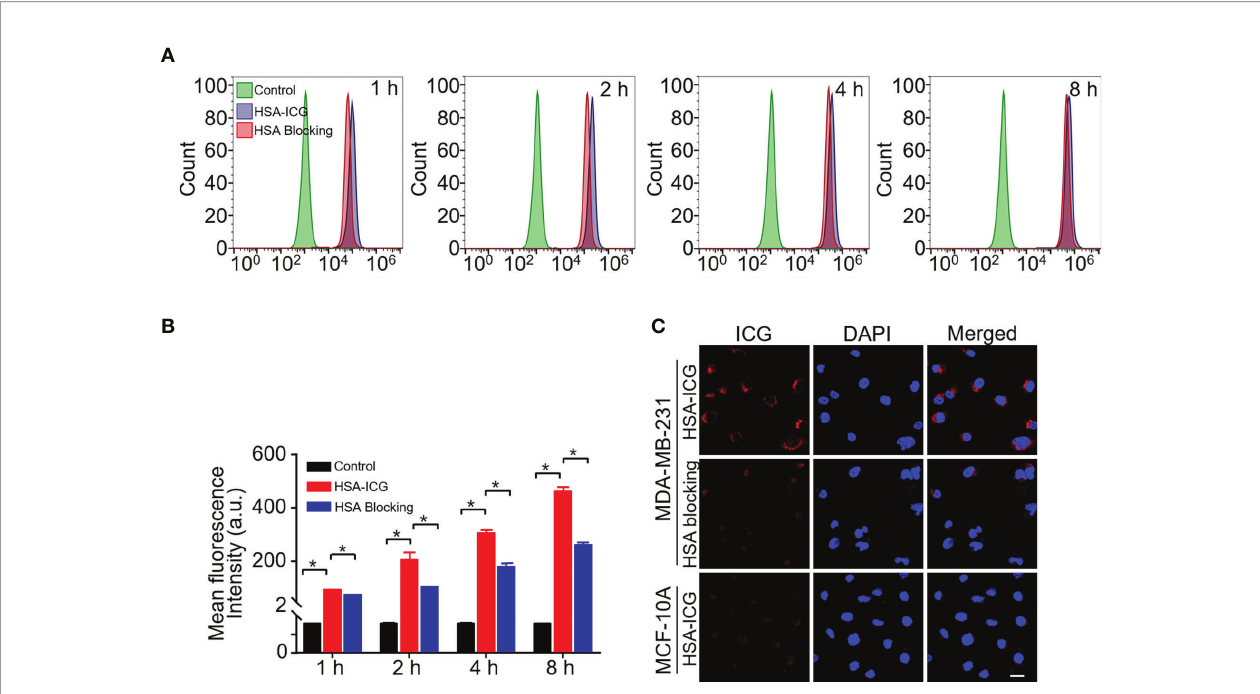
FIGURE 1 | Cell uptake of HSA-ICG. (A) Histogram showing fl ow cytometry based on fl uorescence in MDA-MB-231 cells incubated for 1, 2, 4, or 8 h with HSA- ICG (10 µg/ml) alone or in the presence of excess HSA (10 mg/ml). (B) Mean fl uorescence intensity from the fl ow cytometry in panel A at selected time points (n = 3, one-way ANOVA, * P < 0.05). (C) Confocal laser scanning micrographs of MDA-MB-231 and MCF 10A after 4 h incubation with HSA-ICG. Scale bar = 20